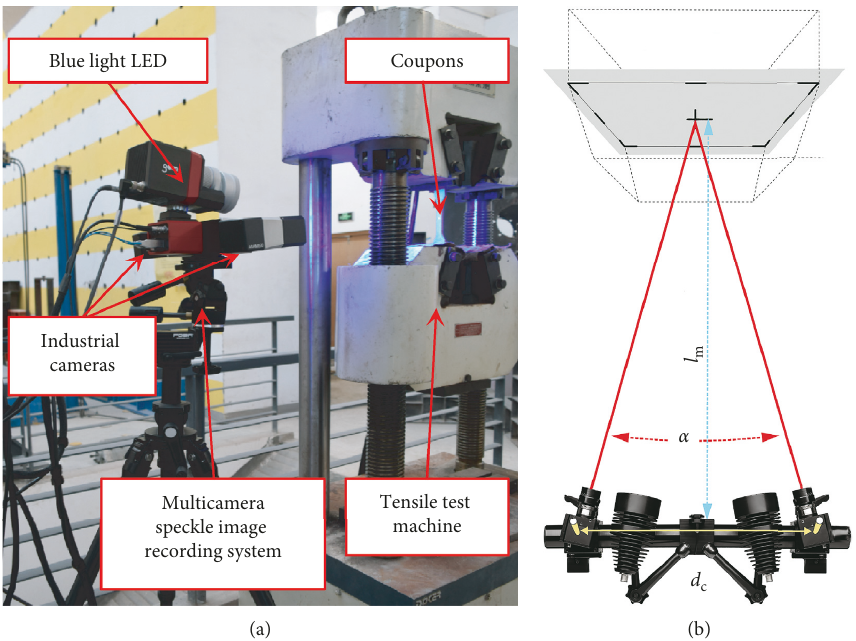
Figure 5: 3D speckle photography measurement system: (a) optical measurement setup; (b) diagram of optical measurement.